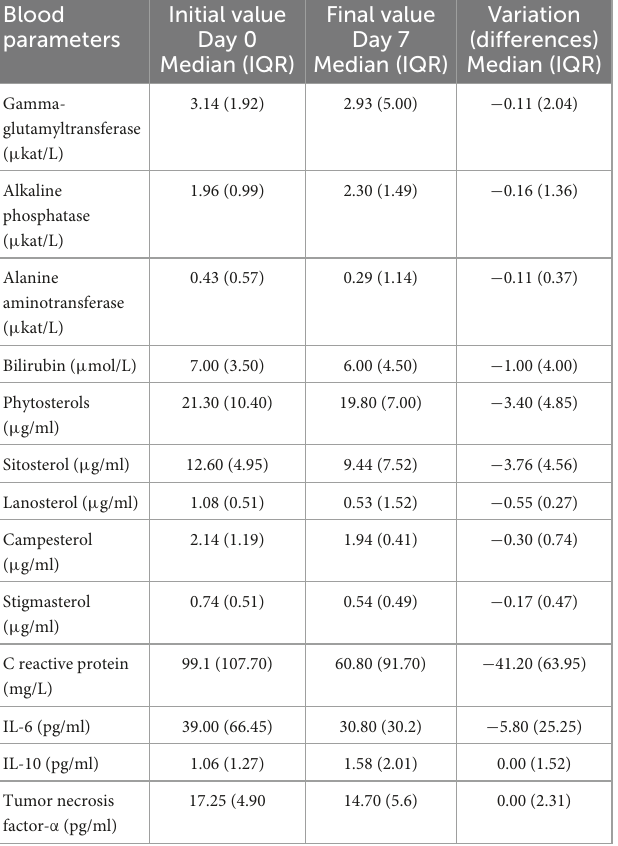
TABLE 1 Analytical parameters: initial values (Day 0), final values (Day 7), and variation between these values. Blood parameters